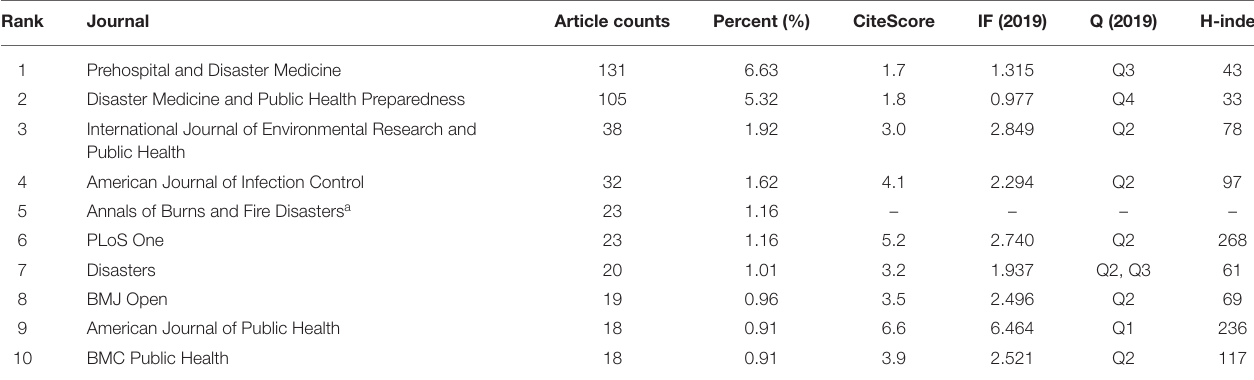
A topic dendrogram ( Figure 4A ), trends of top keywords ( Figure 4B ), and topic trend plot ( Figure 4C ) were